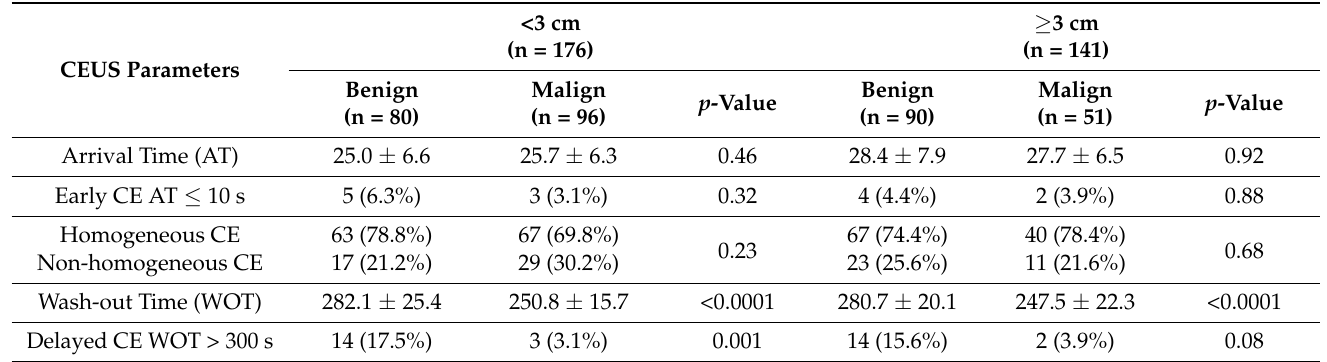
Table 4. Comparison of CEUS parameters between benign and malignant lesions in the small lesion group (average diameter < 3 cm) and the large lesion group (average diameter ≥ 3 cm).